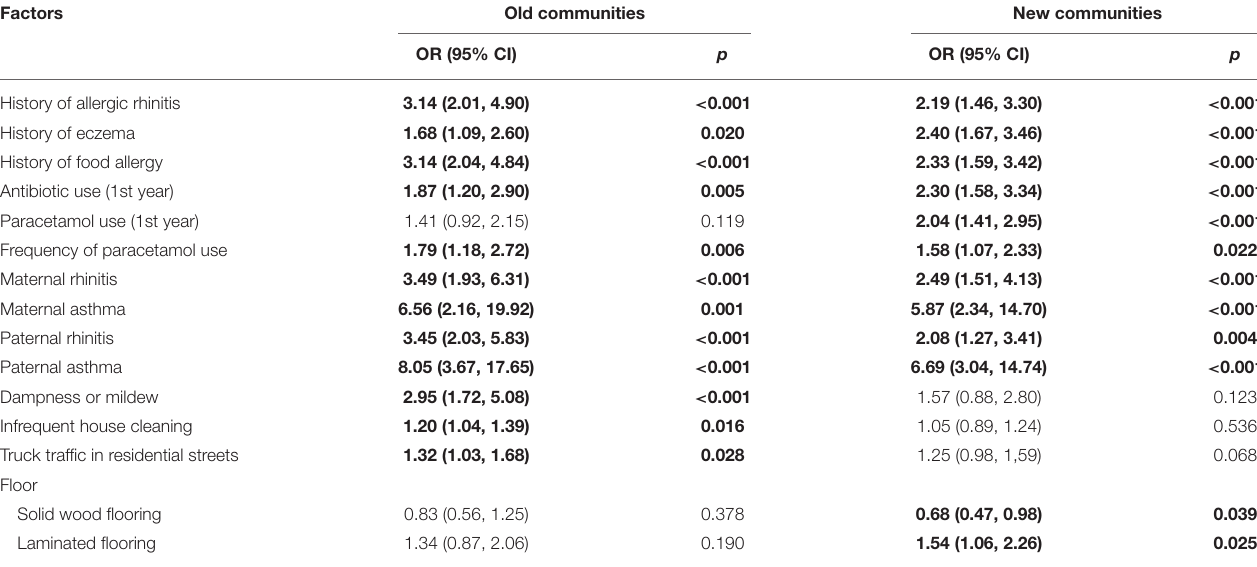
TABLE 5 | The significant risk factors for current asthma in old and new communities analyzed by univariate analyses. Factors Old communities New